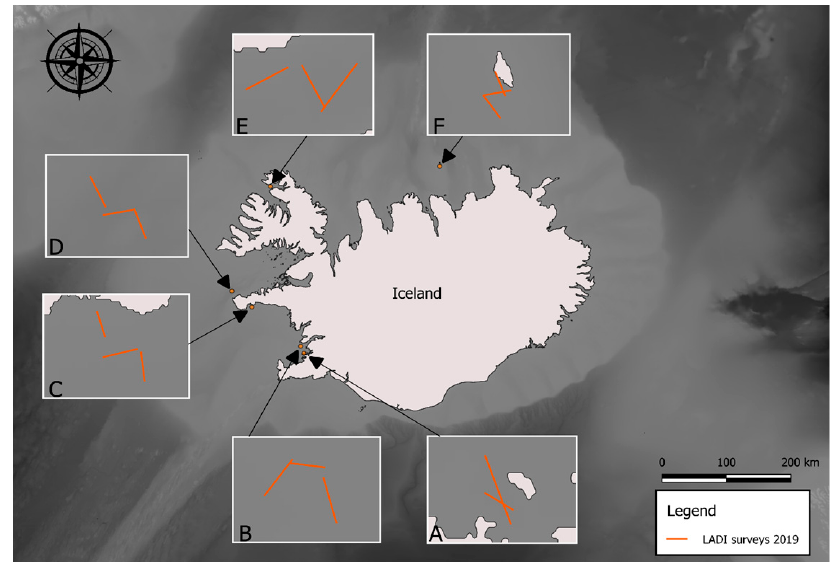
Figure 2. Map of locations of each trawl ( A – F ). The boxes show where the samplings were conducted along the route and further illustrate the specific “zig-zag” path used during each sampling. Sample regions: Reykjavík ( A ), Faxaflói ( B ), Arnarstapi ( C ), Snæfellsnes ( D ), Ísafjörður ( E ), and Grímsey ( F ).